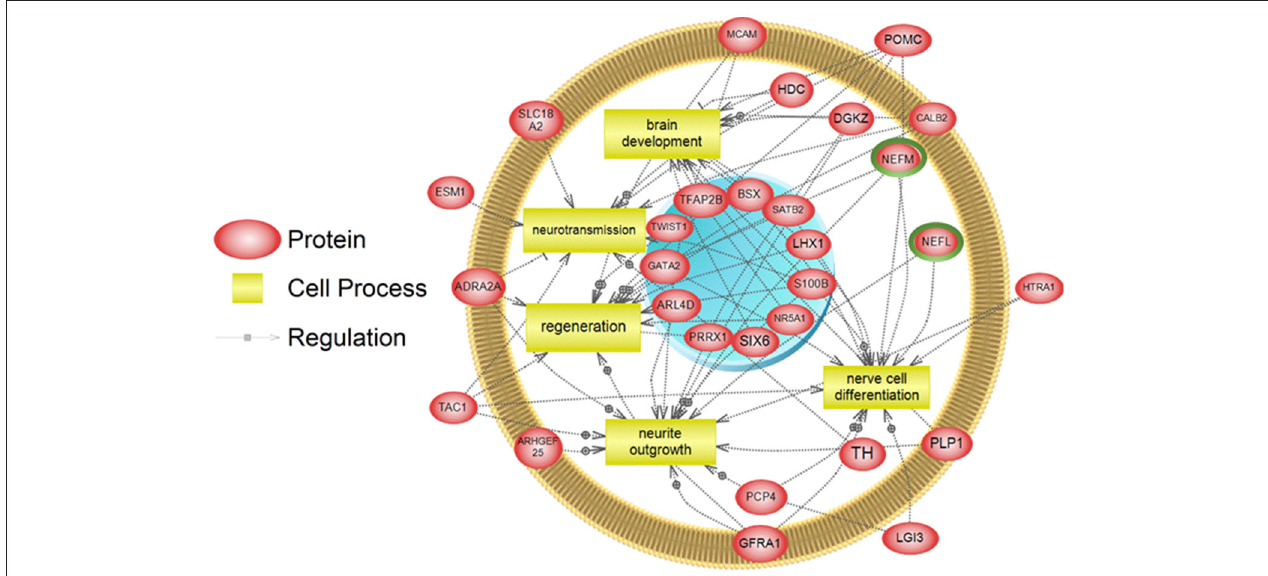
FIGURE 10 | Subnetwork enrichment analysis of the transcriptome for the brain. The figure represents the joining of 5 top pathways identified by the analysis. Genes encircled in green were also found to be enriched in the brain in the proteomics experiment. ADRA2A, adrenoceptor alpha 2A; ARHGEF25, Rho guanine nucleotide exchange factor (GEF) 25; ARL4D, ADP-ribosylation factor-like 4D; BSX, brain-specific homeobox; CALB2, calbindin 2; DGKZ, diacylglycerol kinase, zeta 104kDa; ESM1, endothelial cell-specific molecule 1; GATA2, GATA binding protein 2; GFRA1, GDNF family receptor alpha 1; HDC, histidine decarboxylase; HTRA1, HtrA serine peptidase 1; LGI3, leucine-rich repeat LGI family, member 3; LHX1, LIM homeobox 1; MCAM, melanoma cell adhesion molecule; NEFL, neurofilament, light polypeptide; NEFM, neurofilament, medium polypeptide; NR5A1, nuclear receptor subfamily 5, group A, member 1; PCP4, Purkinje cell protein 4; PLP1, proteolipid protein 1; POMC, proopiomelanocortin; PRRX1, paired related homeobox 1; S100B, S100 calcium binding protein B; SATB2, SATB homeobox 2; SIX6, SIX homeobox 6; SLC18A2, solute carrier family 18 (vesicular monoamine), member 2; TAC1, tachykinin, precursor 1; TFAP2B, transcription factor AP-2 beta (activating enhancer binding protein 2 beta); TH, tyrosine hydroxylase; TWIST1,Twist homolog